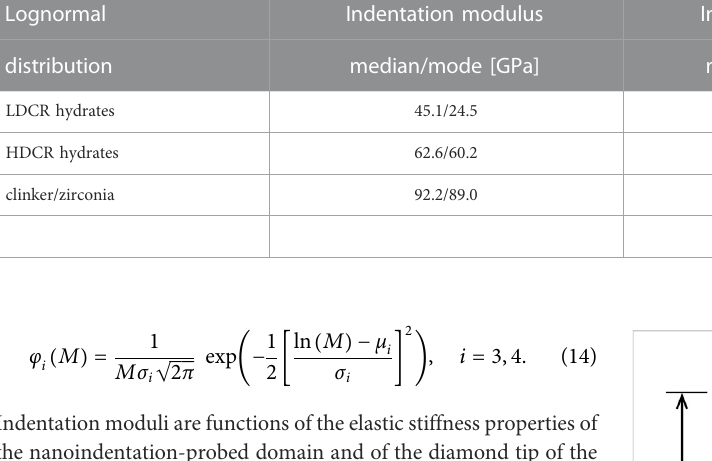
TABLE 7 Results obtained from grid nanoindentation testing (Dohnalík et al., 2021): values of medians, modes, and volume fractions associated with the three lognormal distributions representing the histogram of indentation moduli in Figure 9. Lognormal